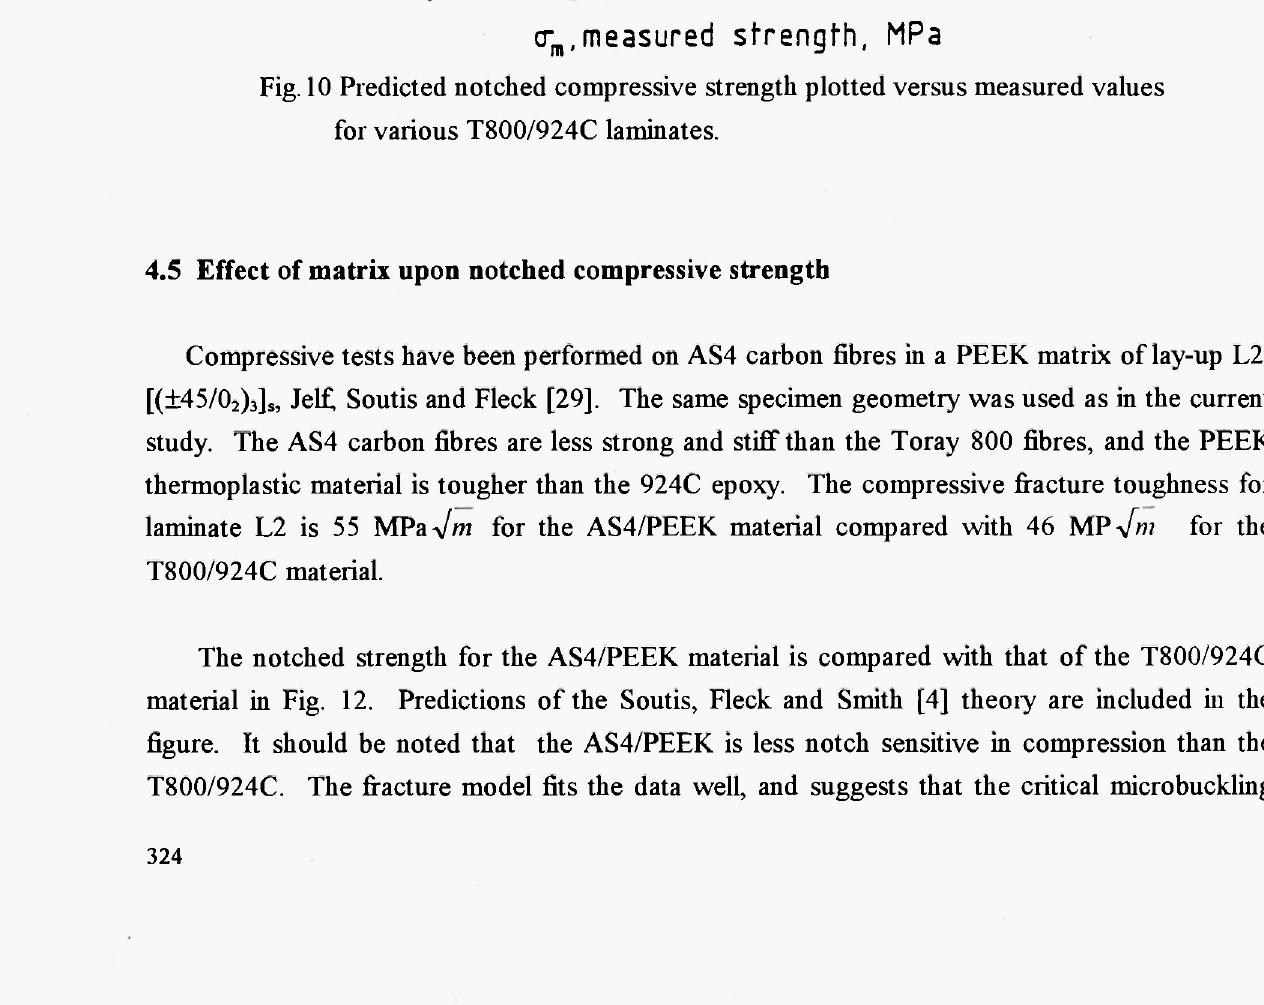
strength, Fig. 10 Predicted notched compressive strength plotted versus measured values for various T800/924C